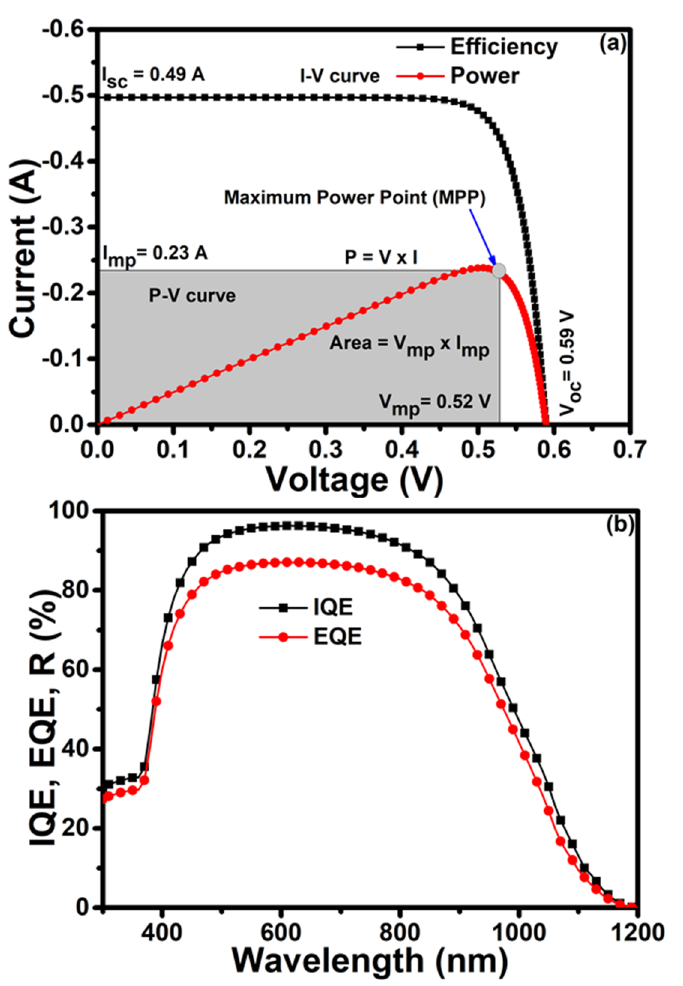
Figure 8. ( a ) I-V curve with a power curve and ( b ) incident photon-to-electron conversion efficiency (IPCE) curve of Si solar cells based on ZnO NRs antireflection (AR).